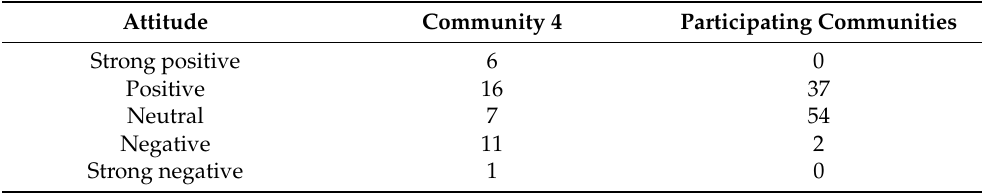
Table 2. Reported feelings of Community 4 ( n = 41) and the participating communities ( n = 93) toward Kibale National Park.